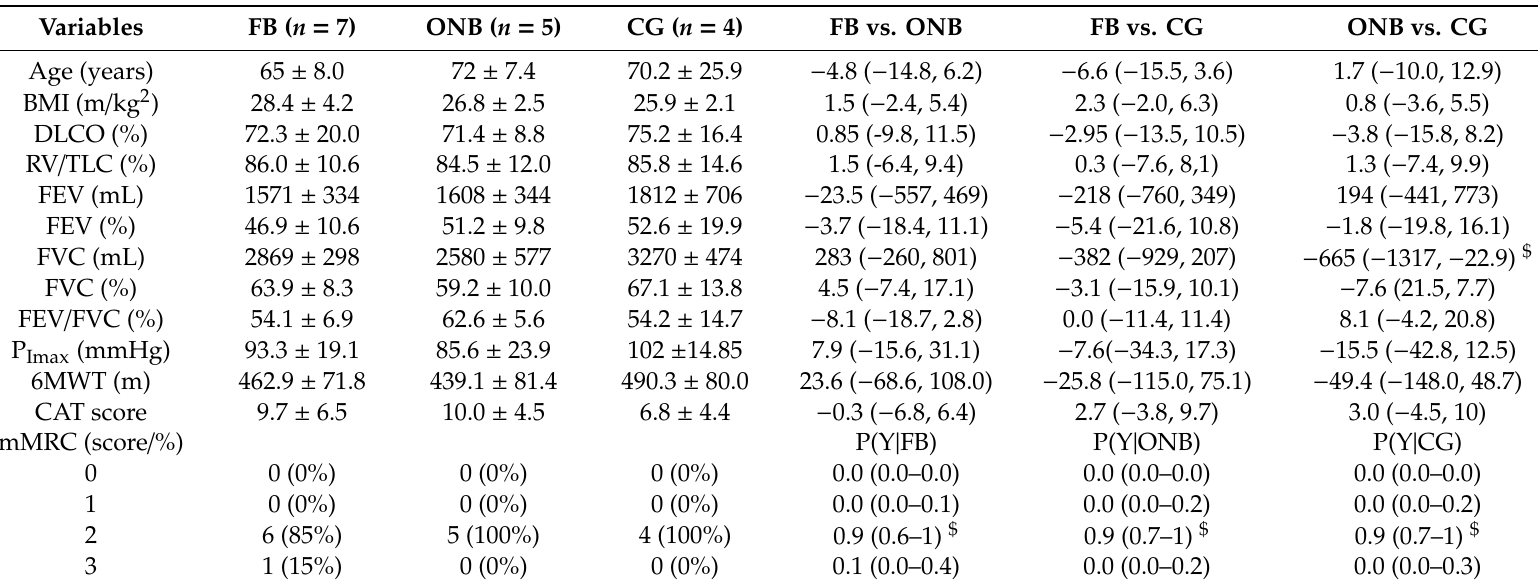
Table 1. Baseline characteristics of the